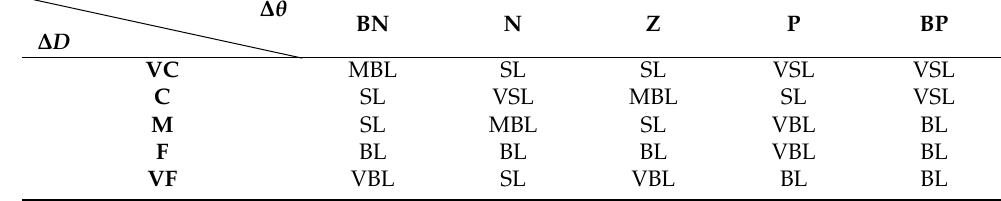
Table 13. The suboptimal rules for the left wheel angular velocity.